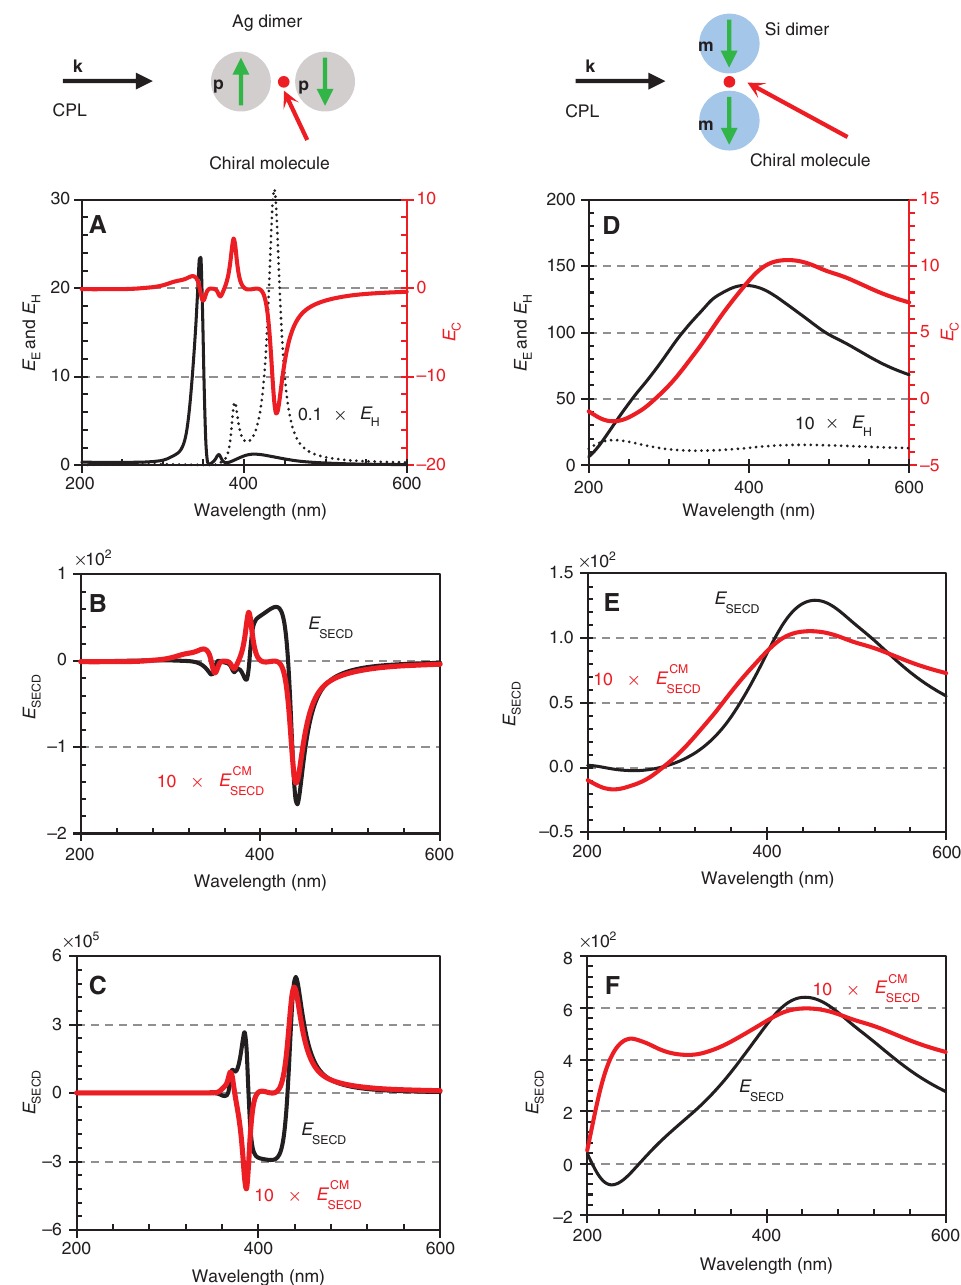
and (C, F) CM from (A–C) Ag dimer and (D–F) Si dimer. (A, D) Electric ( E E1 − M1 E2 − M2 = | H | 2 / | H | 2 , black dotted) and optical chirality enhancement E H 0 E (red) of (B, E) CM (black) and CM and (C, F) CM . Ag dimer has a radius of 30 nm and a gap distance of 6 SECD E1 − M1 E2 − M2 SECD